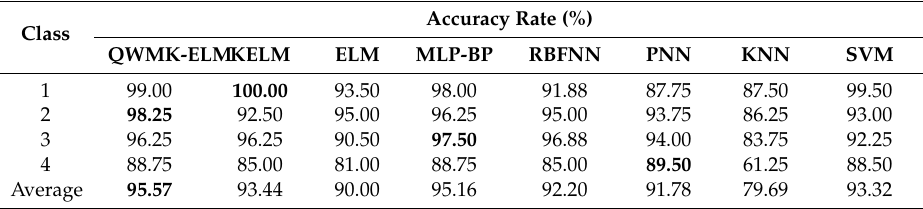
Table 6. Classification accuracy of QWMK-ELM and the control methods for Dataset II.